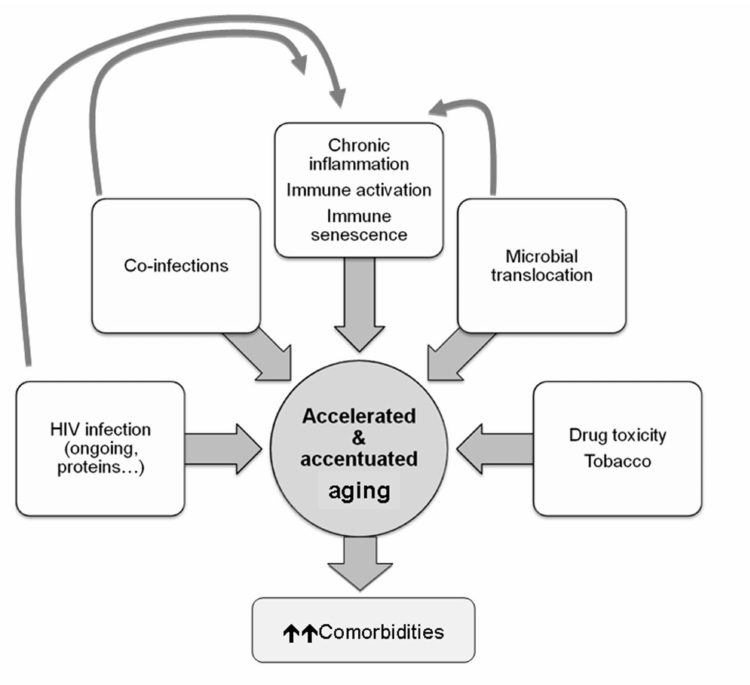
Figure 4. Main causes and consequences of HIV